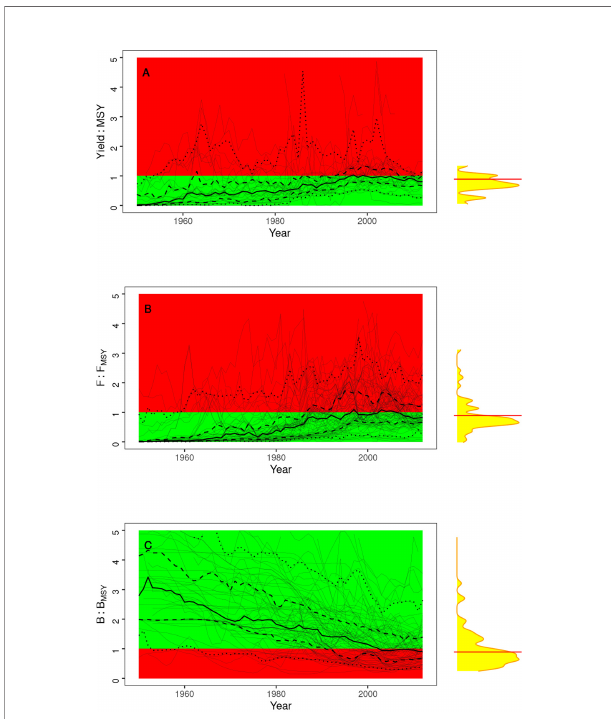
FIGURE 1 | Time series relative to MSY benchmarks for the RAM Legacy database assessments; the faint lines represent individual stocks, the thick line the median trend, the thick dashed lines the interquartile range, and the thin dashed lines the 90 th percentiles. States relative to the MSY benchmarks in the nal year are shown as marginal densities; for (A) Yield/ MSY (B) F/FMSY (C) SSB/BMSY